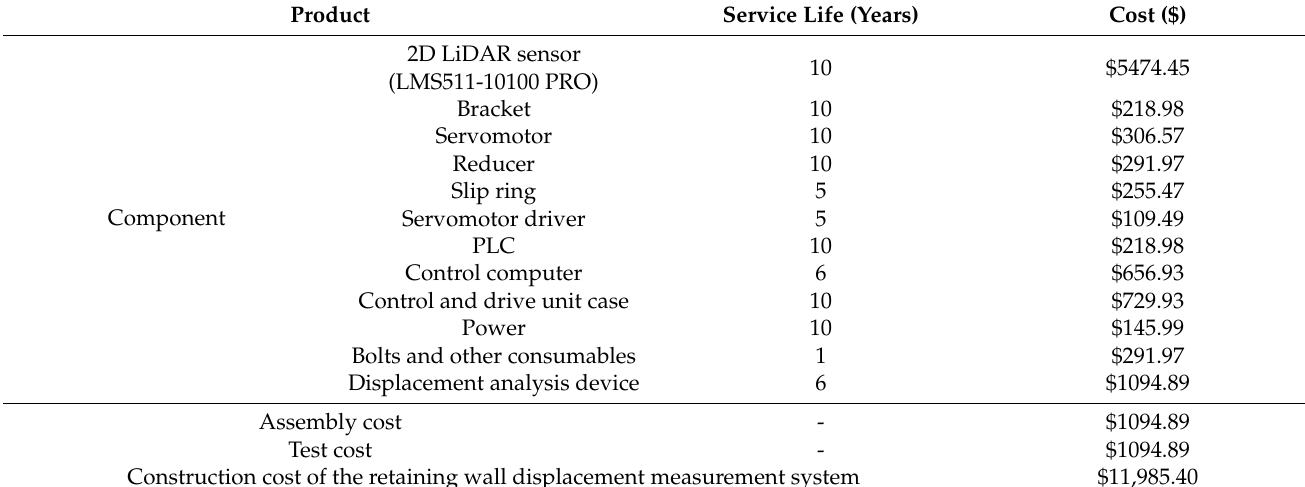
Table 8. Construction cost for retaining wall displacement measurement systems and component costs.